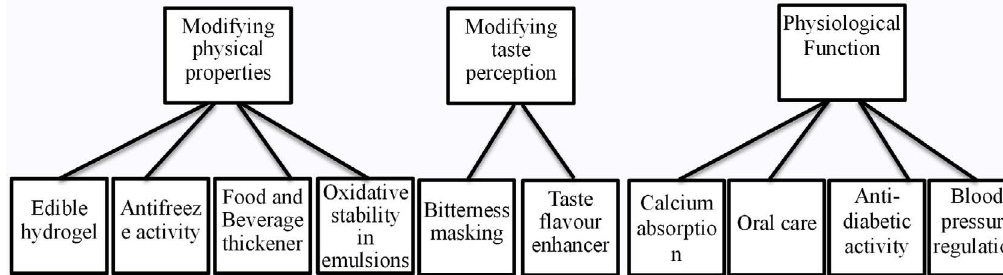
Fig. 5. Schematic representation of scope of PGA in Food applications